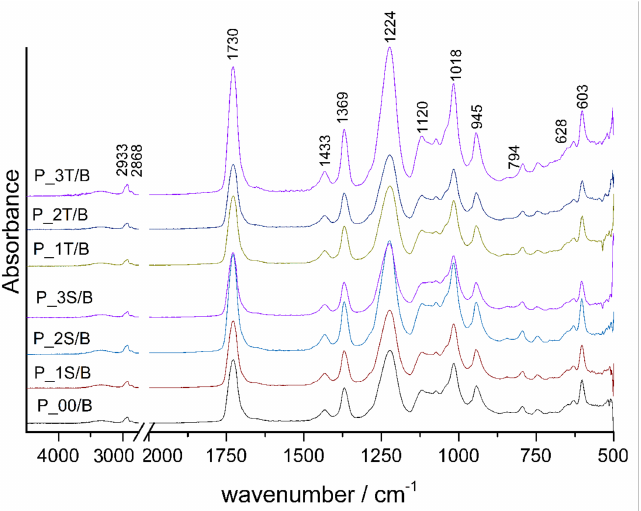
Figure 7. The FTIR spectra of paper B adhesive sample (P_00 / B, P_1S / B, P_2S / B, P_3S / B, P_1T / B, P_2T / B, P_3T /